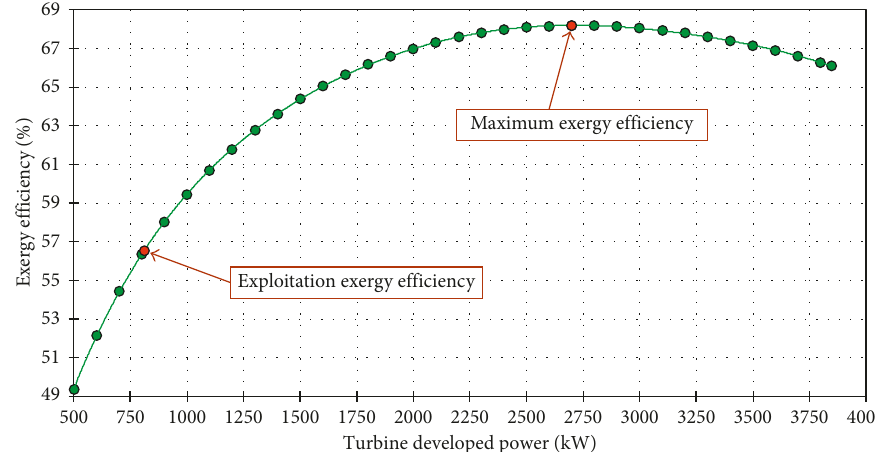
Figure 3: Steam turbine exergy efficiency change during the developed power variation—operating point